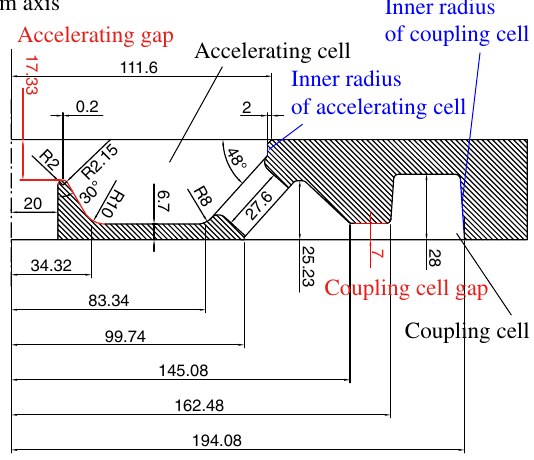
FIG. 1. Cell geometry of the ACS debuncher